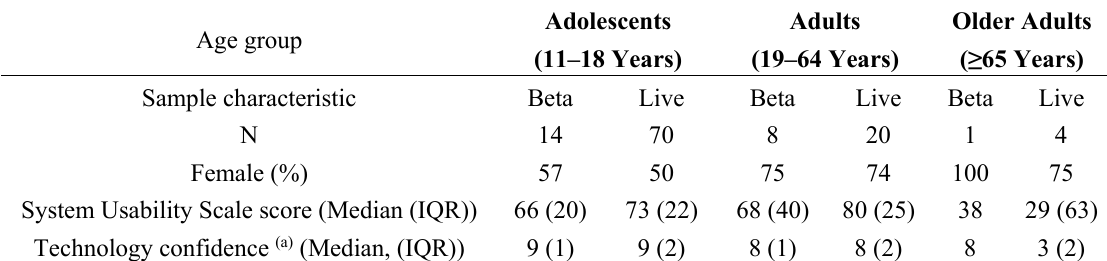
Table 4. Sample characteristics by age group and system usability scale (SUS) scores for participants completing usability testing of the beta and live versions of